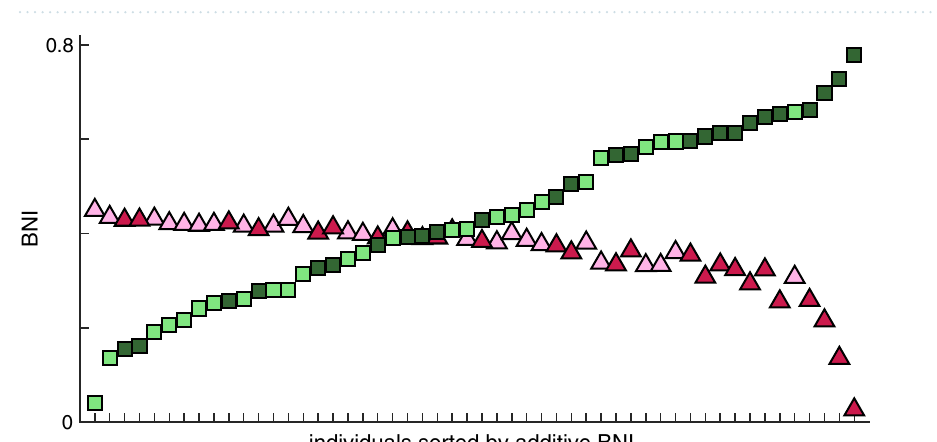
Figure 8. Comparison of NI distributions using different couplings. The weighted Kendall correlation rank τ quantifies the consistency of ordering nodes according to their NI values when using the different couplings. The blue bars correspond to the comparison between additive and diffusive coupling, the red bars correspond to additive versus mixed coupling, and the green bars to the diffusive versus mixed coupling. Different panels show the comparison for different network topologies: ( a ) undirected random, ( b ) directed random, ( c ) undirected scale-free random, and ( d ) directed scale-free networks. The error bars represent the standard error across the 10 network realisations per network topology. All parameters are the same as in Fig. 7.